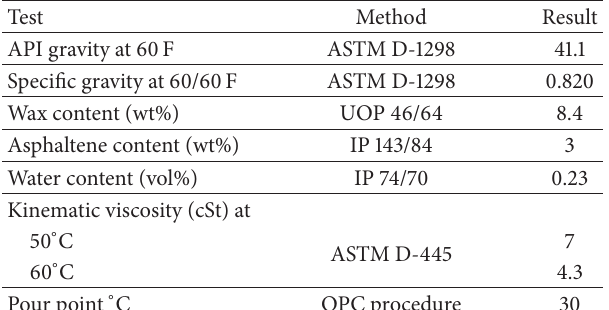
Table 1: The physicochemical properties of Norpetco crude